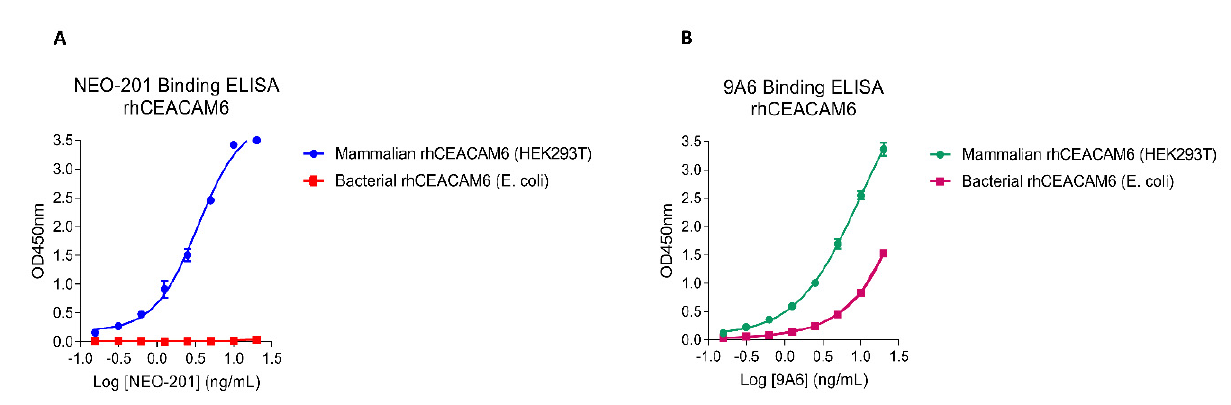
Figure 1. NEO-201 binding to mammalian rhCEACAM6 by ELISA. HEK293T: mammalian rhCEA- CAM6 (post-translational modification-competent). E. coli : bacterial rhCEACAM6 (post-translational modification-incompetent). rhCEACAM6 was used at 400 ng/mL. NEO-201 ( A ) and 9A6 ( B ) were used at two-fold dilutions down from 20 ng/mL.